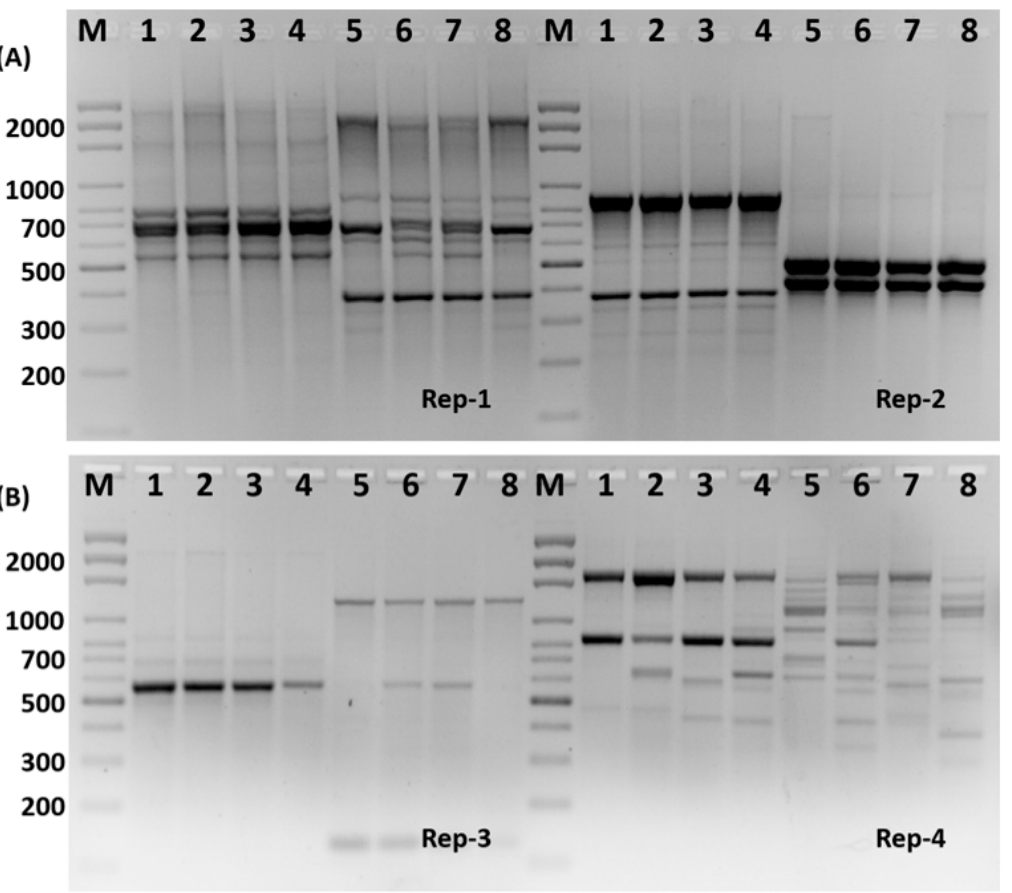
Figure 6. Rep-PCR profile of treated Staphylococcus aureus ( A ) and klebsiella penomenas ( B ) strains generated with Rep primer No. 1–4 using different concentration of Ca-Alg 2 -CH/CPT nanocomposites (2–4), 1 = untreated strains. M: is 100 bp DNA ladder, the concentrations of Ca-Alg 2 -CH/CPT nanocomposites 1, 2, and 3 mg/mL, respectively.